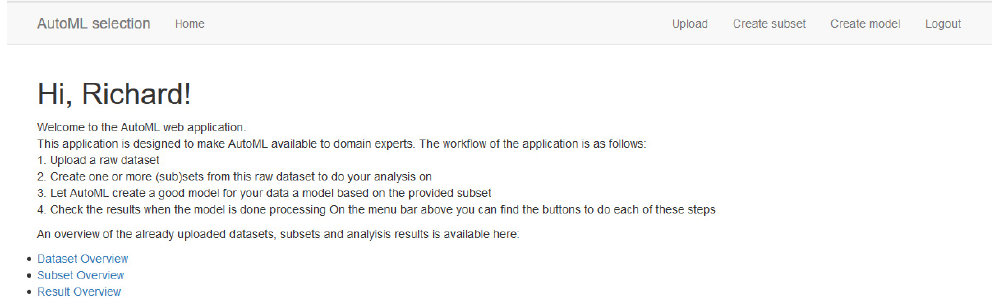
Figure A1. Screenshot 1 of of AutoML artefact A, the Web application interface (preference: GUI). Appl. Sci. 2020 , 10 , 2992